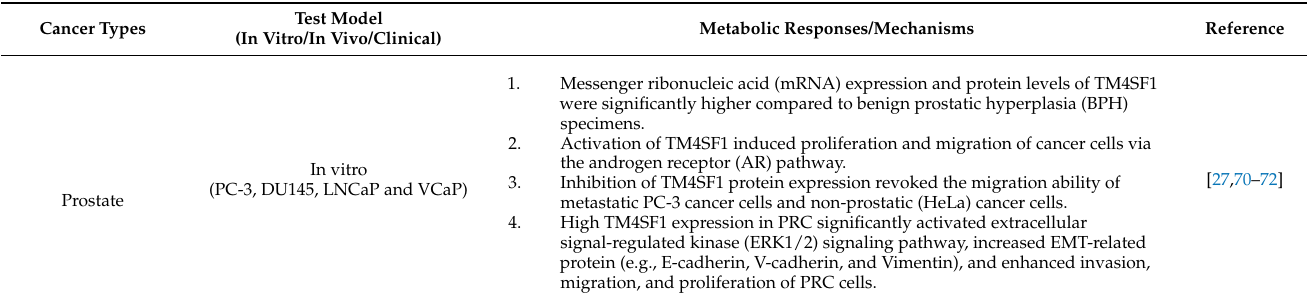
Table 1. Molecular expression, regulatory roles, biomolecular interactions, and the underlying mechanism of actions of TM4SF1 in different cancers against cancer phenotypes and